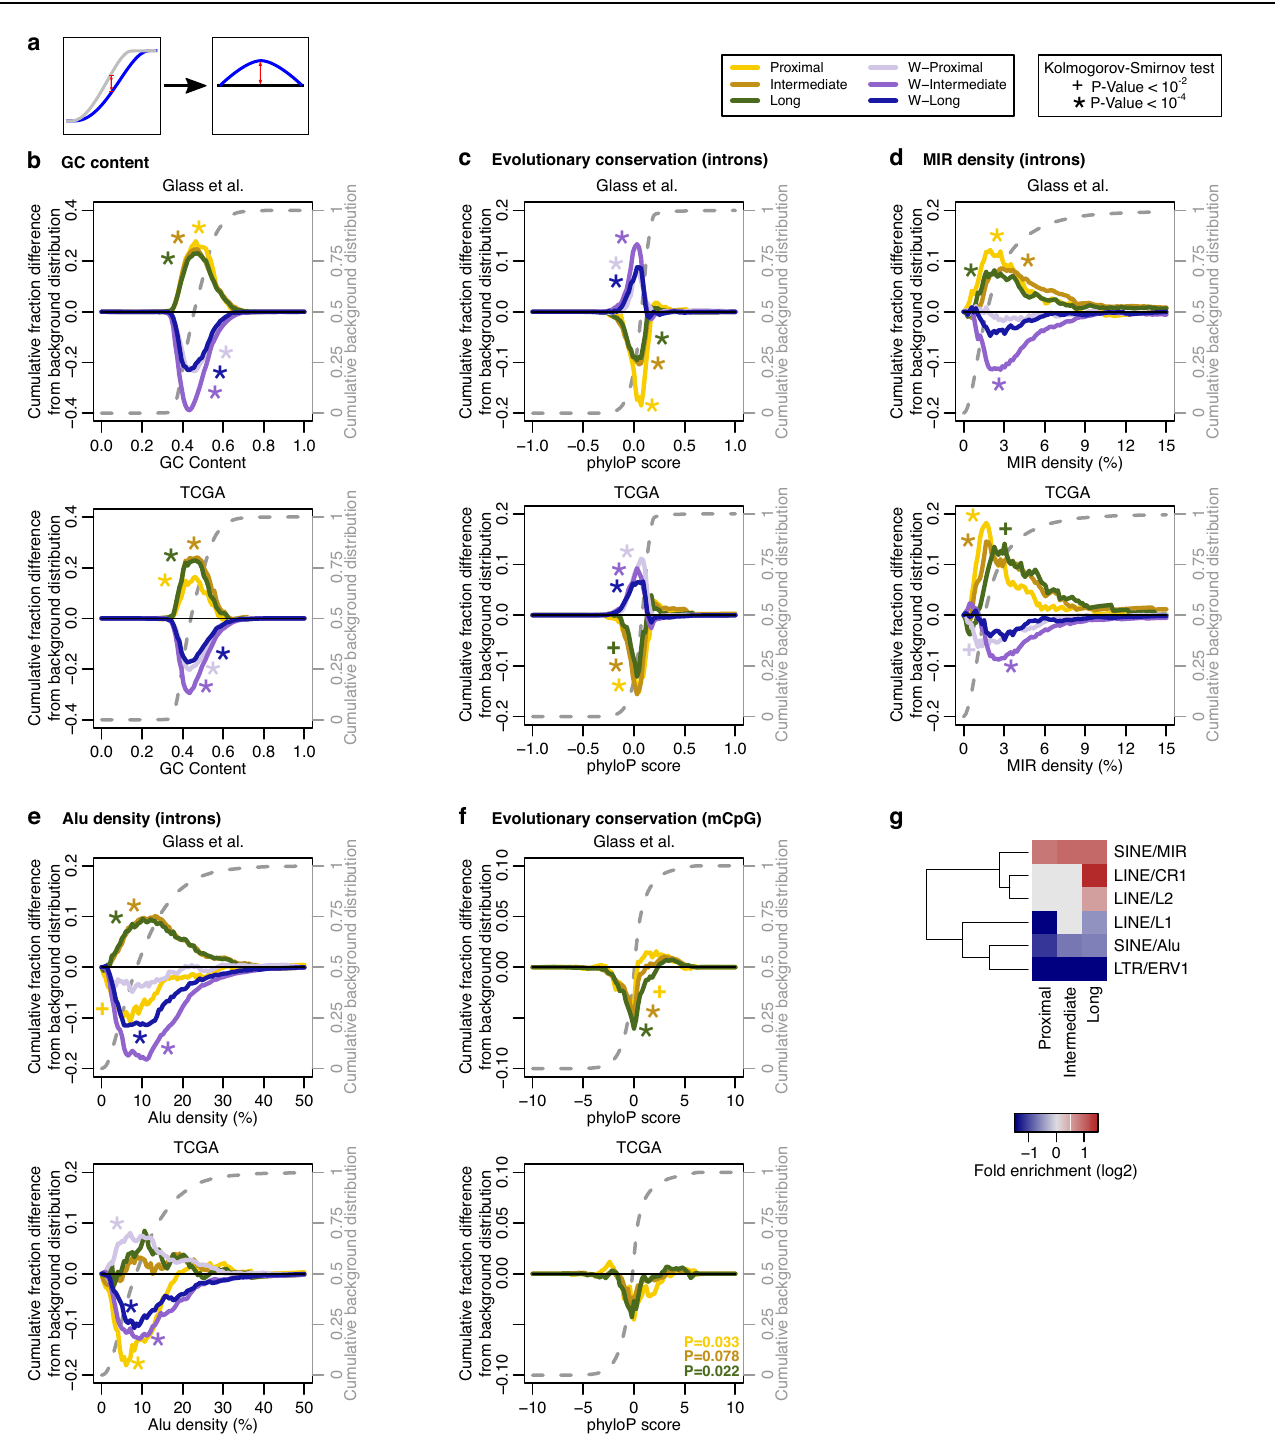
Fig.2|Antitheticalarchitectureofintronsofgeneswithcoupledvs.uncoupled expression-methylation.a Descriptionofthe informationpresentedontheplots. Speci fi cally, plots show the difference between the cumulative distribution of the background genes (dashed gray line) and the cumulative distribution of the respective gene set. b – e Architectural parameters of the introns of the genes with signi fi cant expression-methylation correlations at proximal ( n =413 for Glass et al. and 347 for TCGA), intermediate ( n =1749 and 680) or long range ( n =1344 and 478),andofthe 1000geneswiththe weakestexpression-methylationcorrelations, i.e.,theWgenesets.Plotsshowthedifferencebetweenthecumulativedistribution of the background genes (dashed gray line) and the cumulative distribution of the respective gene set. Positive values mean a shift of the distribution toward higher